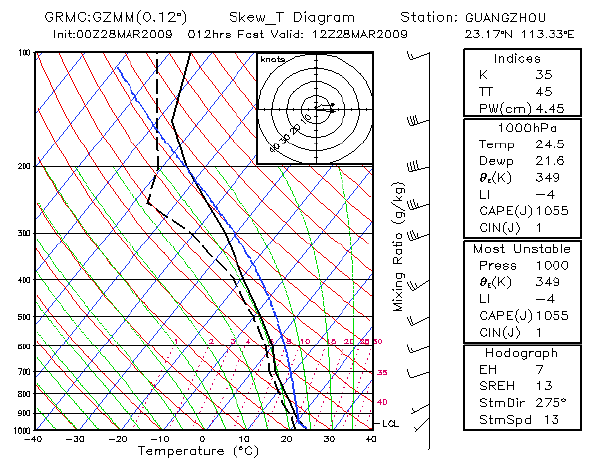
Fig. 4. Atmospheric sounding in Guangzhou (113.33 ◦ E, 23.17 ◦ N) at 00:00UTC on 28 March 2009. The black solid line corresponds to the temperature, and the black dash line represents the dew point